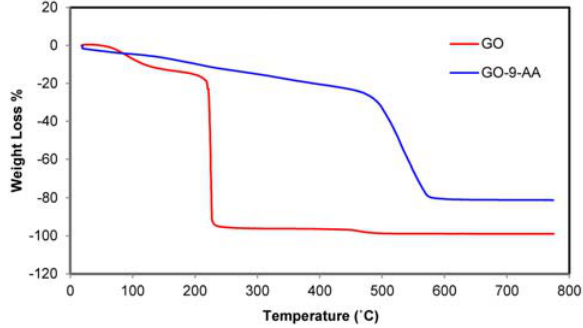
of GO after amidation has been eliminated, suggesting ex- foliation of layered in